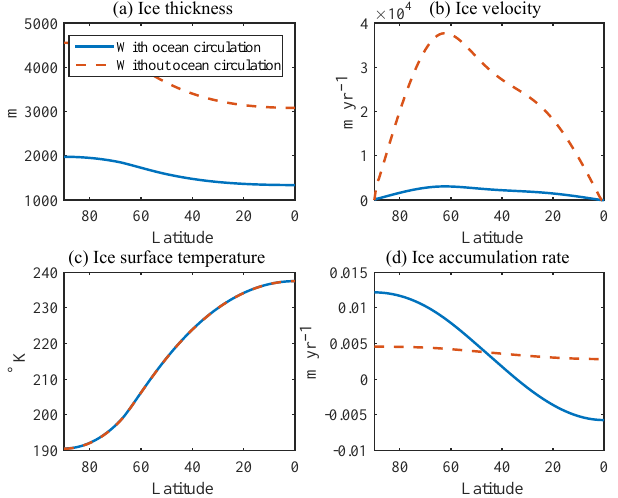
Figure 3. (a) Ice thickness h and (b) velocity v profiles with 94% insolation, F geo = 0 . 08Wm − 2 , and effective emissivity ε = 0 . 83, the Snowball Earth scenario. (c) Ice surface temperature T s , which is seen to not be impacted by ocean circulation. In (d) , the sim- ulation without ocean circulation cannot reach steady state due to geothermal heat not reaching the ice layer.